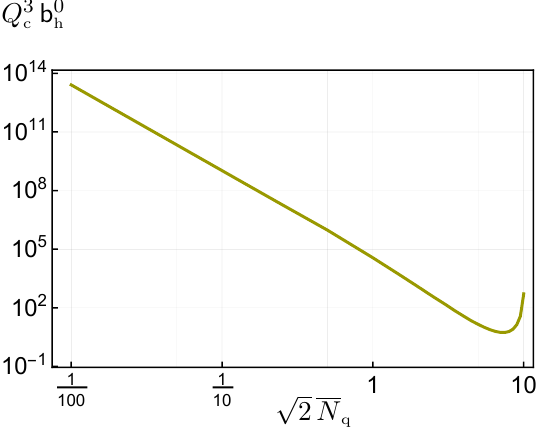
Figure 6. Fit of the function b 0